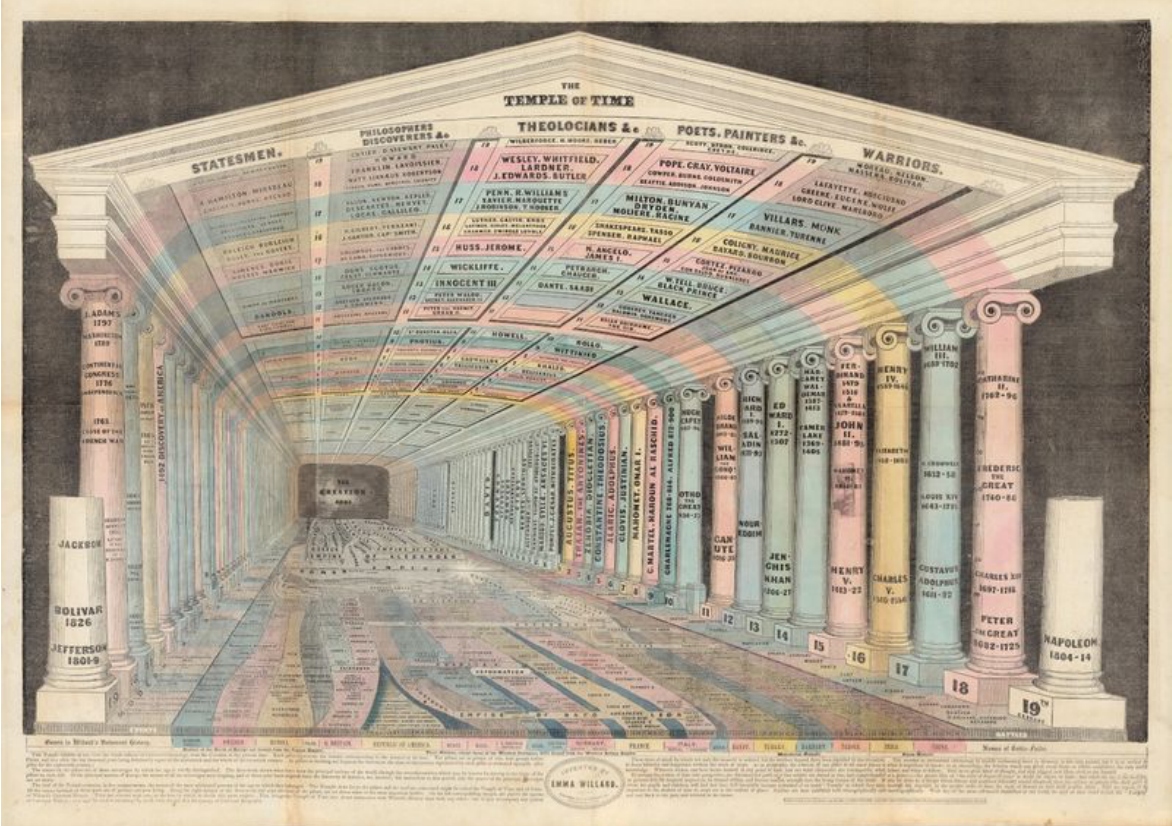
Figure 19. Emma Willard’s perspectival Temple of Time (1846). Image courtesy of the David Rumsey Map Collection, David Rumsey Map Center, Stanford